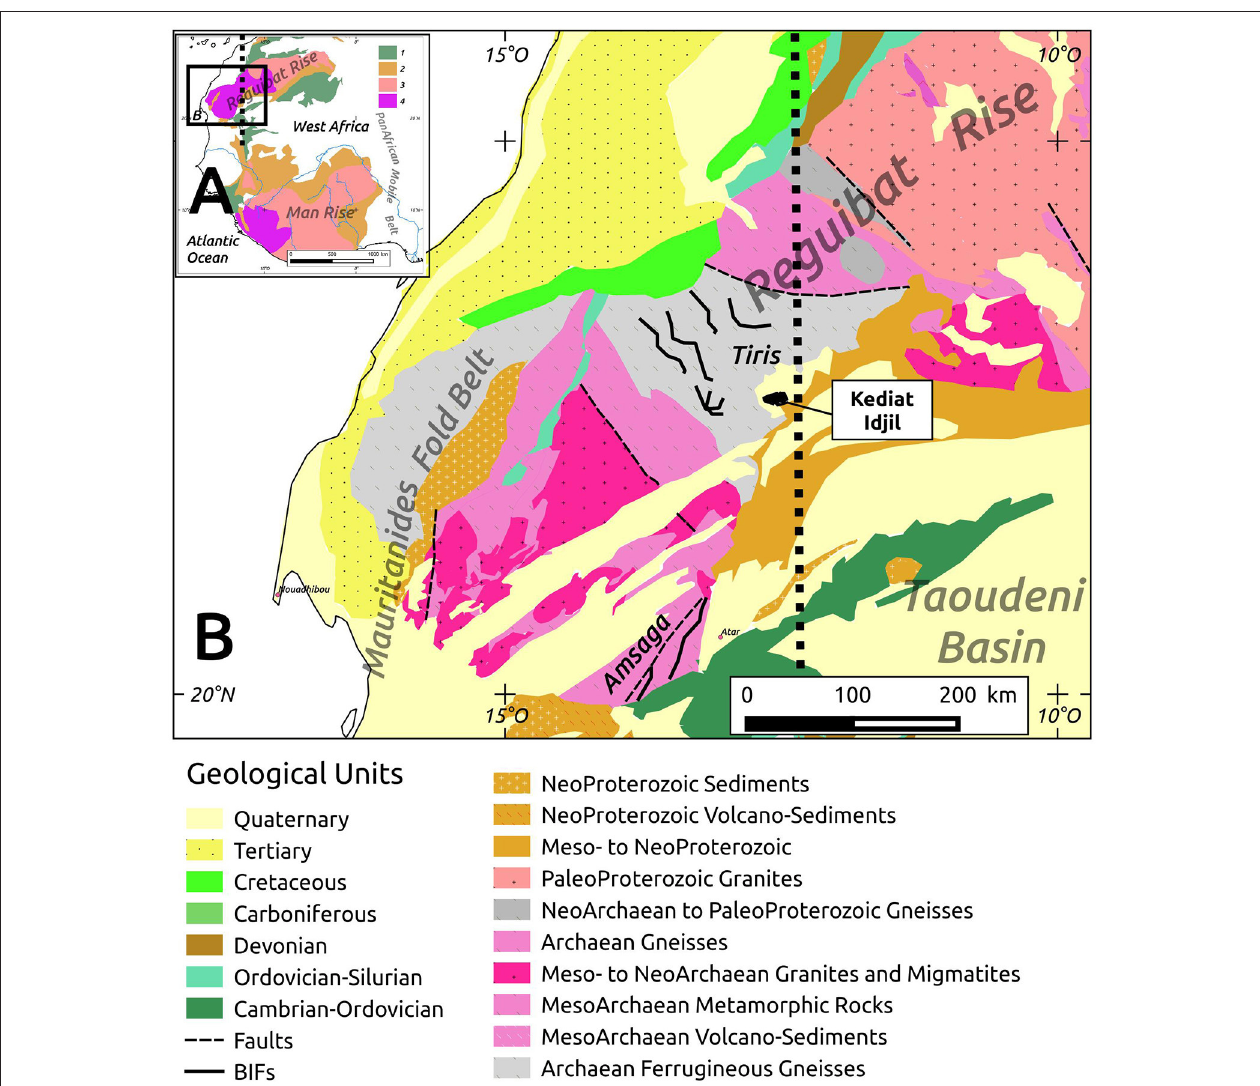
FIGURE 2 | Geological context of the studied area at large scale in the West African Craton (A) and at regional scale in the Reguibat Ridge (B) . All samples come from drillings in the Banded Iron Formations (BIFs) of the Kediat Idjil (6 samples), Tiris (12), and Amsaga (4) regions. In (A) , 1—Palaeozoic (Hercynian) Rocks, 2—Meso- to NeoProterozoic Rocks, 3—NeoArchaean to PalaeoProterozoic Rocks, and 4—Archaean Rocks. On both maps, the thick dashed solid line shows the location of the magnetic field data main profile selected for modeling. Map modified from Bronner (1990) and Thièblemont et al. (2016).